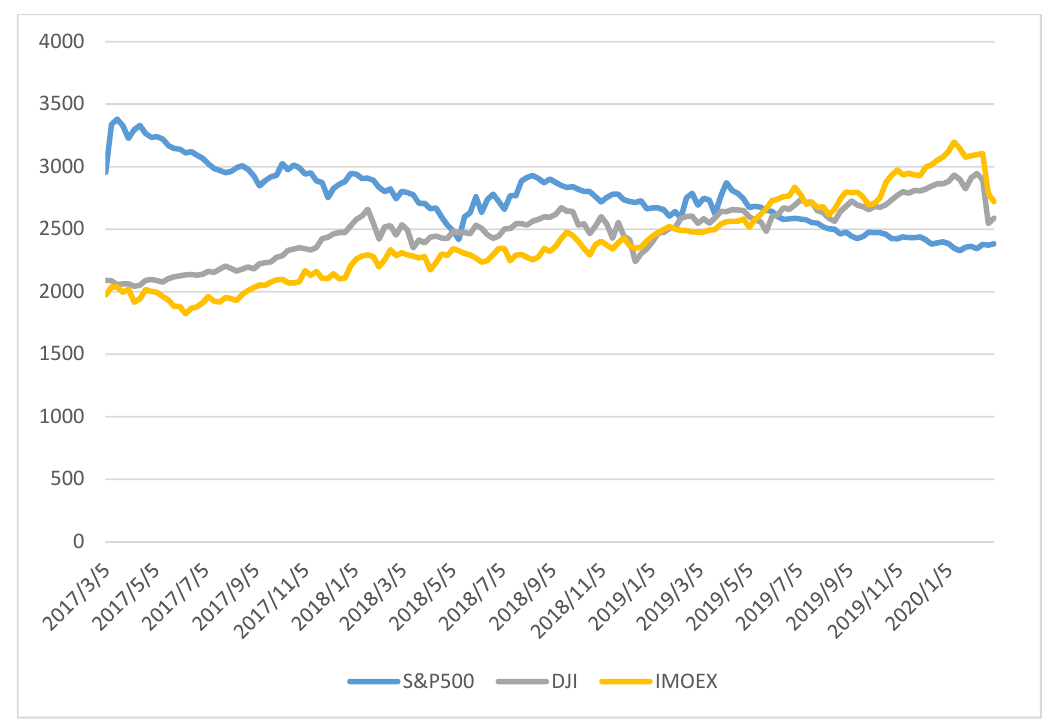
Figure 4. Dynamics of stock indices. Source: Blockchain.com (accessed on 18 March 2021),